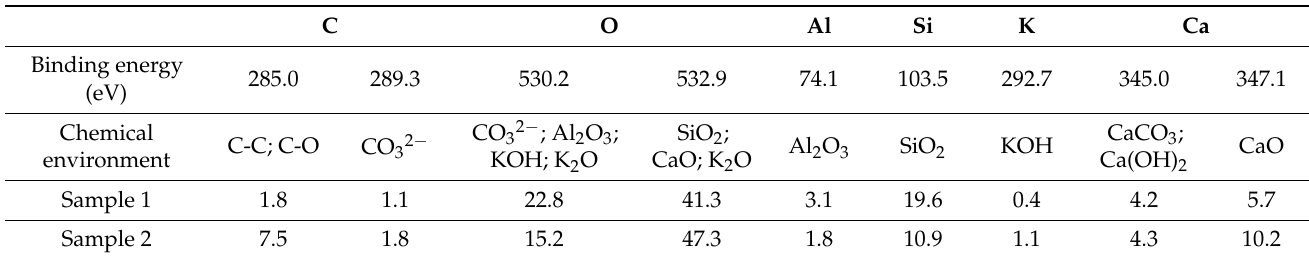
Table 3. Summary list of atomic concentrations (at%) of elements with breakdown into matched chemical environments.